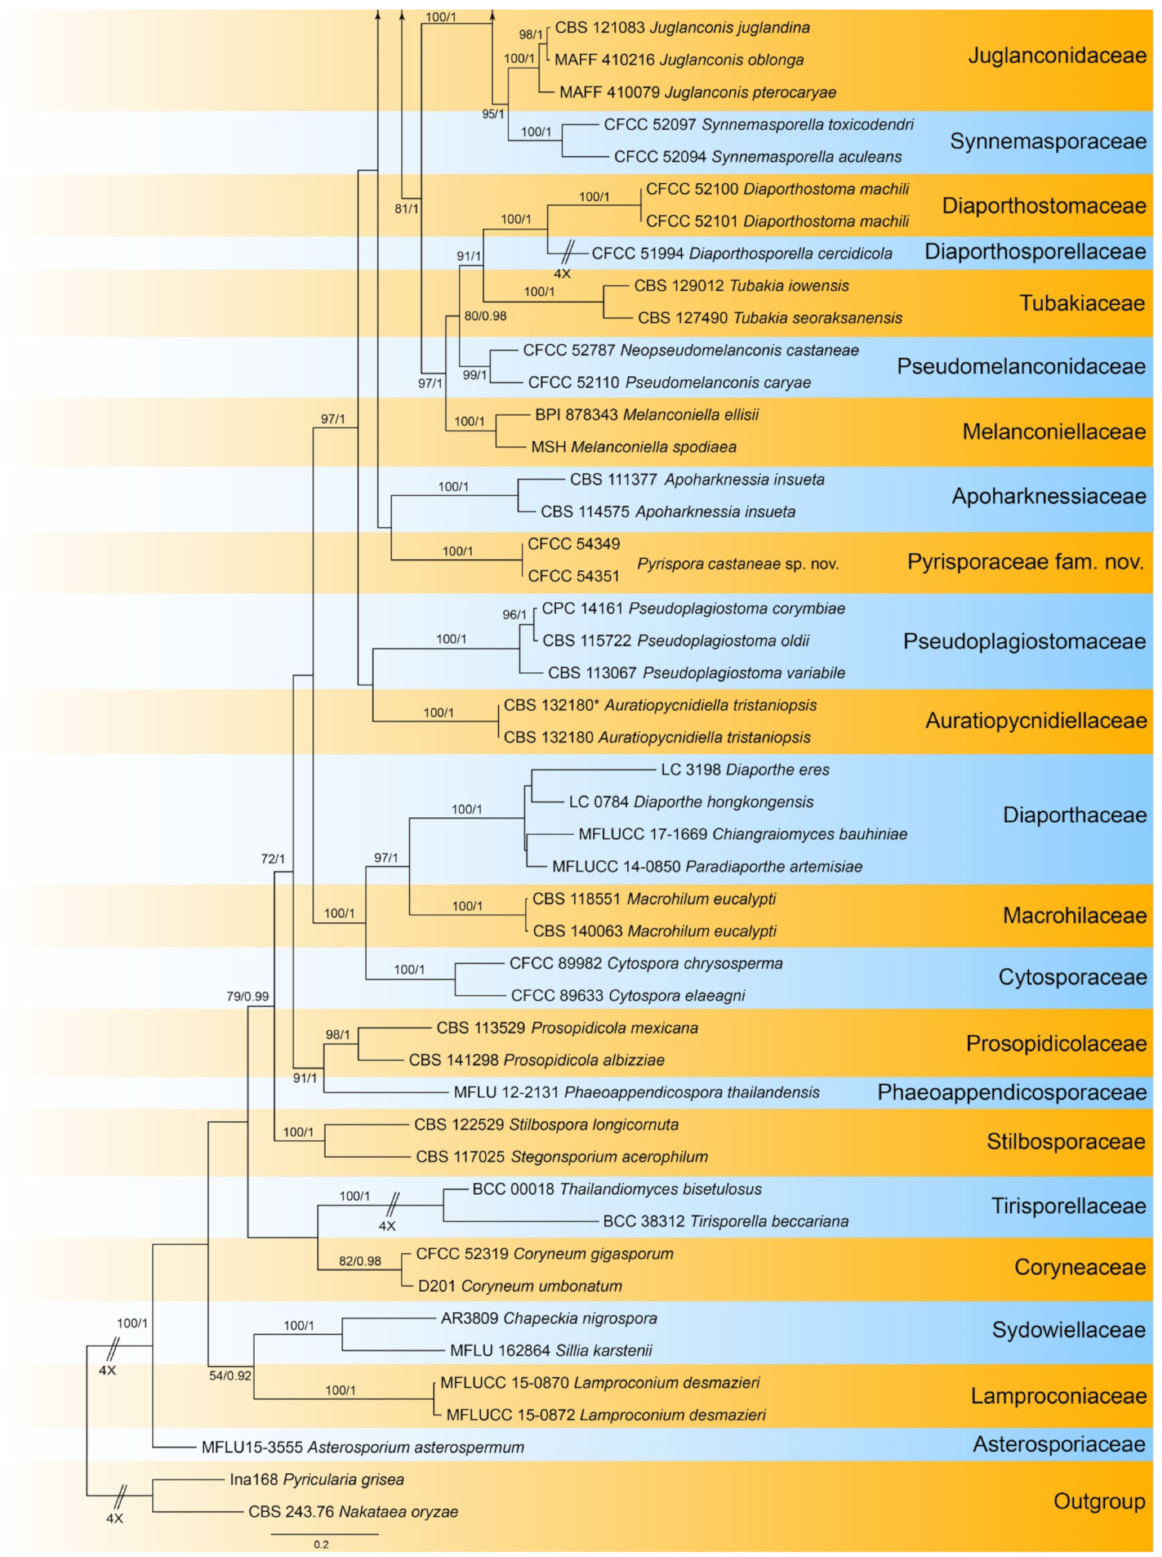
Figure 23. Phylogram generated from RAxML analysis based on combined ITS, LSU, tef1 and rpb2 sequence data of Diaporthales isolates. The tree was rooted to Pyricularia grisea (Ina 168) and Nakataea oryzae (CBS 243.76). The scale bar indicates 0.2 nucleotide changes per